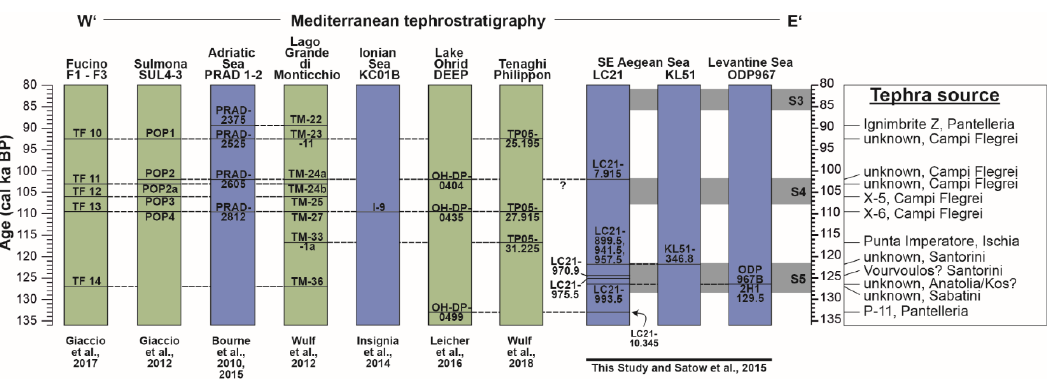
Figure 8. Tephrostratigraphic correlations of MIS 5 terrestrial and marine sediments in the Eastern Mediterranean region. See Figure 1 for position of sites. Core and tephra data derive from: Fucino palaeolake, central Italy [90]; Sulmona palaeolake, central Italy [92]; PRAD 1–2, central Adriatic Sea [5,30]; Lago Grande di Monticchio, southern Italy [4]; KC01B, Ionian Sea [46]; Lake Ohrid, Albany/Macedonia [93]; Tenaghi Philippon, northeastern Greece [32]; LC21, KL51 and ODP967B (this study). Positions of sapropels S3–S5 are included for comparison.